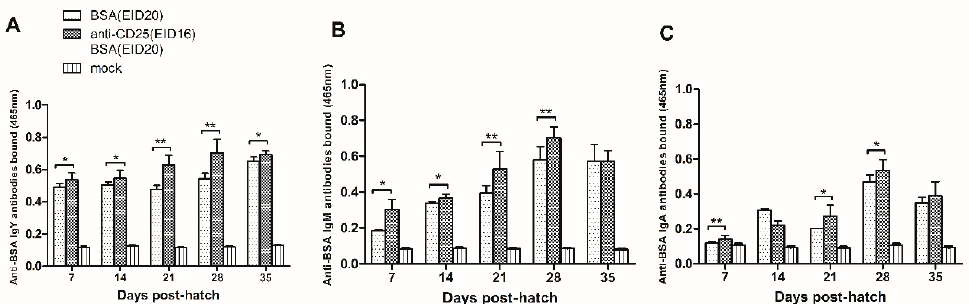
Figure 5. Serum anti-BSA antibody analysis by ELISA: ( A ) the bound anti-BSA IgY antibodies; ( B ) the bound anti-BSA IgM antibodies; ( C ) the bound anti-BSA IgA antibodies. y-axis means the OD value at 465 nm. The error bars indicate the SEM. * p ≤ 0.05; ** p ≤ 0.01.